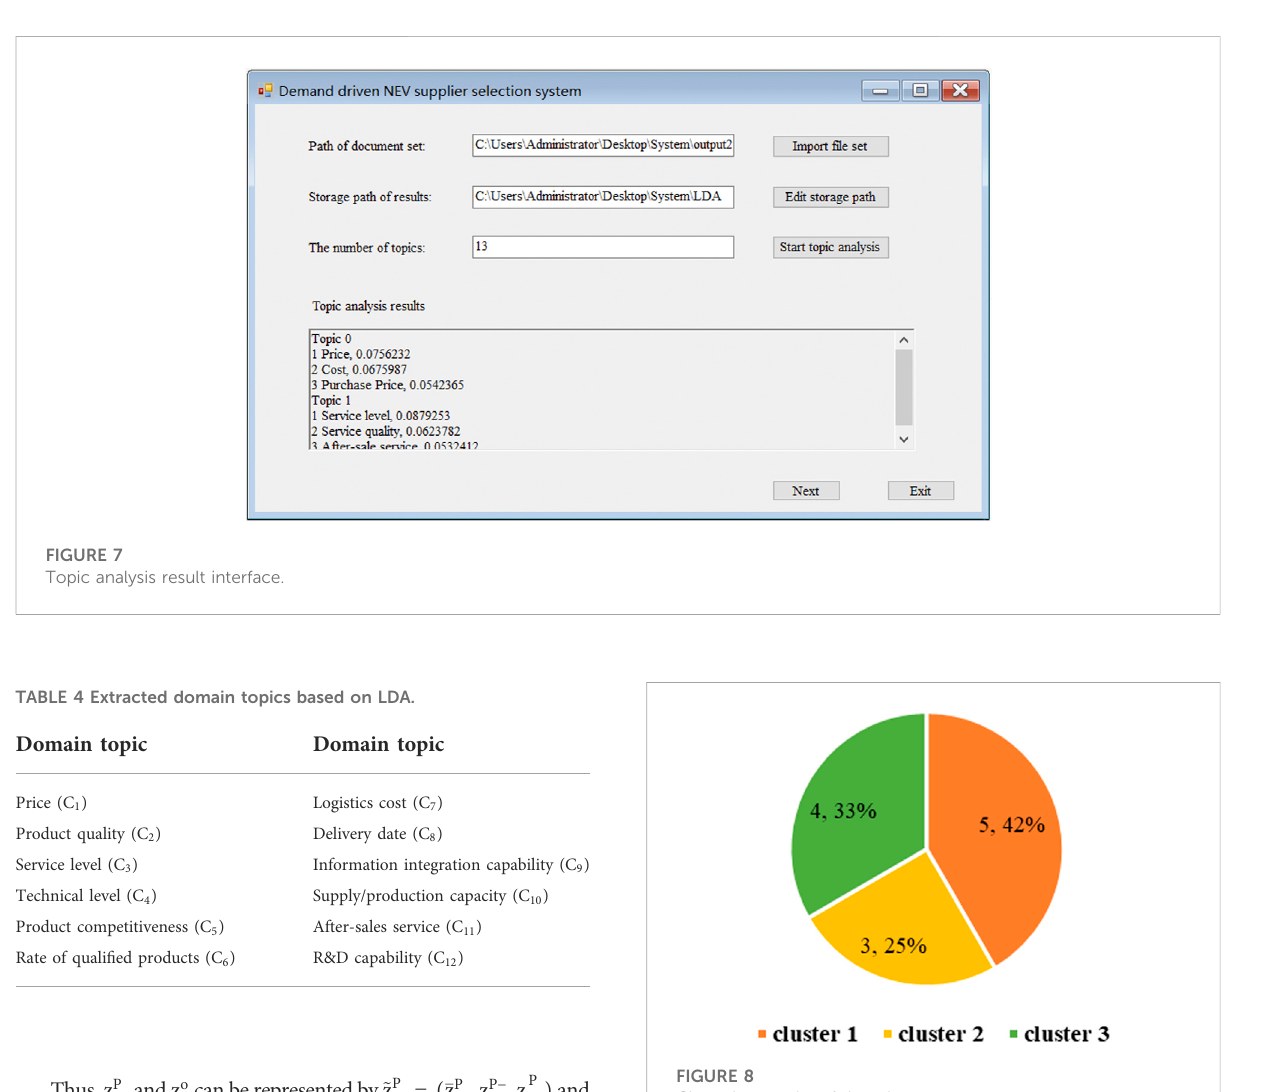
FIGURE 8 Clustering results of domain